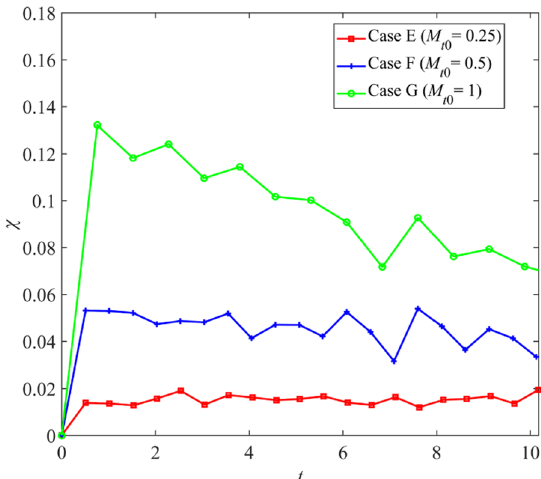
K c turb / K turb for cases E, F and G =